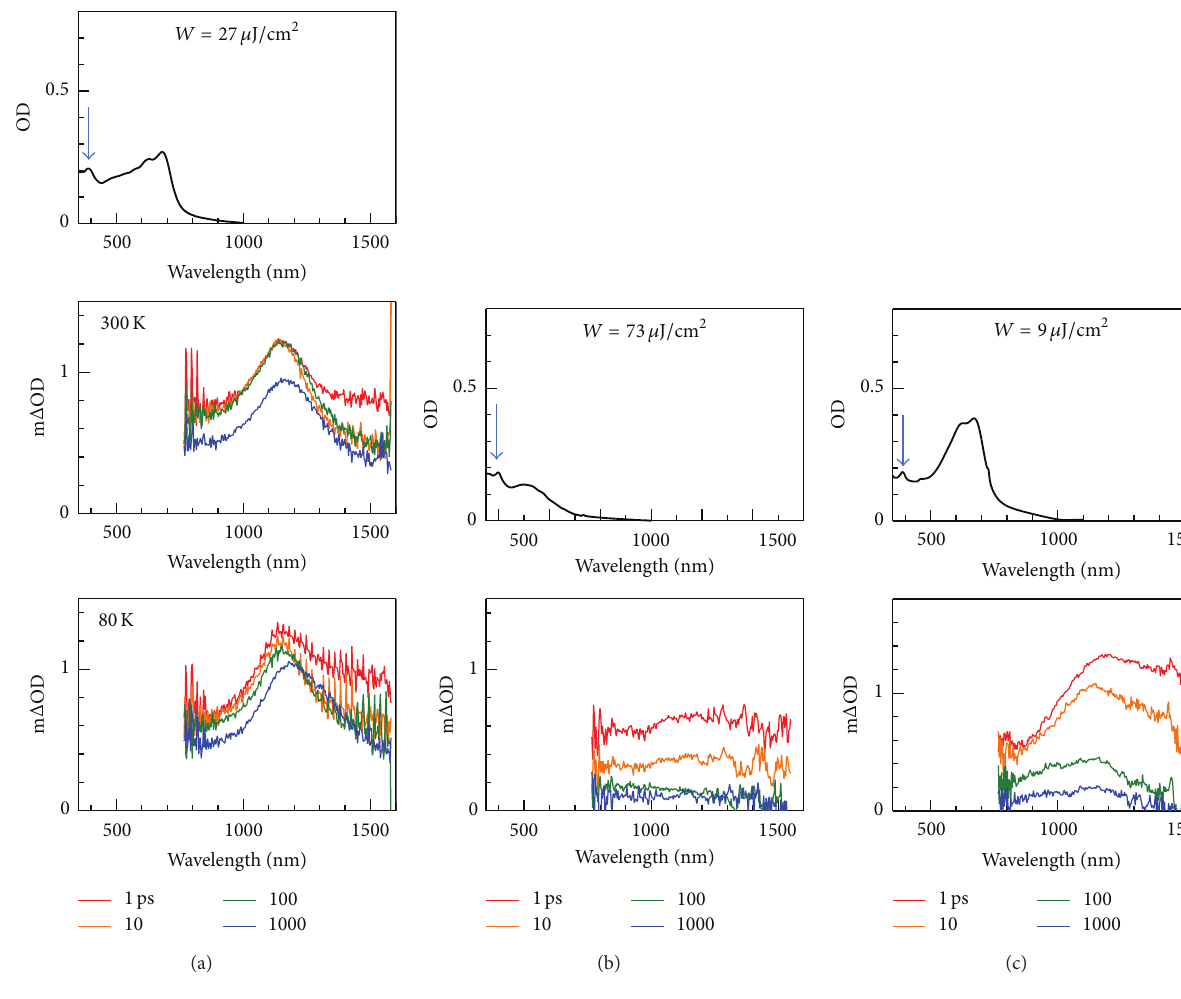
Figure 12: Δ OD spectra of (a) PTB7/C 70 bilayer, (b) C 70 neat, and (c) PTB7 neat films. Top panels show optical density (OD) of the films at 300 K. Downward arrows represent the wavelength of the pump pulse. The data were replotted from